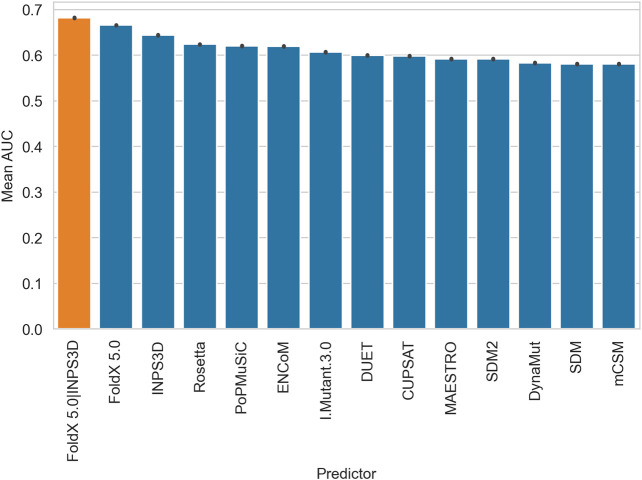
Barplots displaying the performance (AUC) of all the ΔΔG predictors and the consensus (orange) of the best two performing methods (FoldX5.0 and INPS3D). The bars represent the mean AUC obtained by averaging balanced subsets (the available pathogenic variants were matched with a random sample with the same number of benign variants for one hundred times).